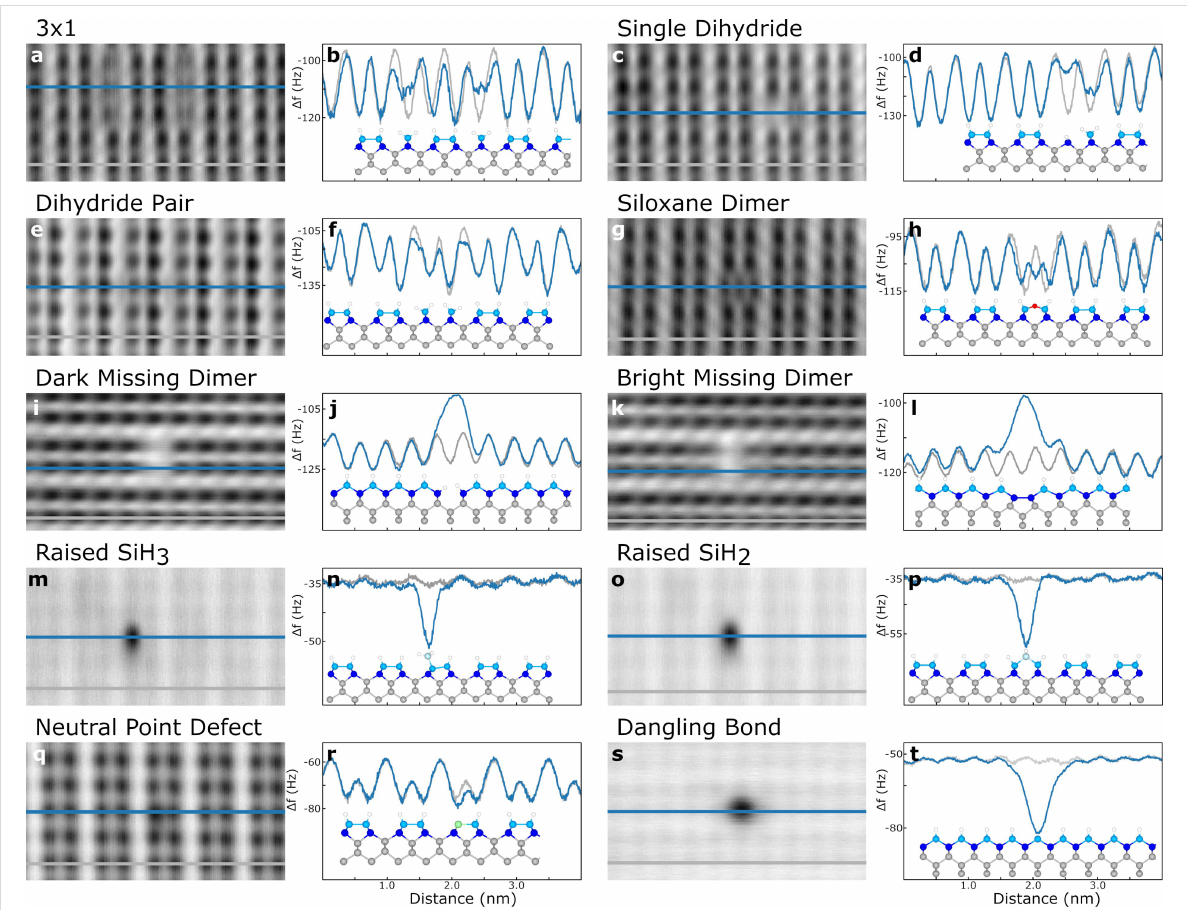
Figure 3: Analysis of defects using dark-contrast AFM and profile extractions. Line cuts of the AFM scans using Si-terminated tips were performed by averaging over 6 adjacent lines, with the thickness of the line profile indicating this averaging. The defect-including profiles are indicated in blue, while the defect-free profiles for each panel are in grey. The defect type is indicated above the relevant panels. See Figure 2 for the experimental image pa- rameters.